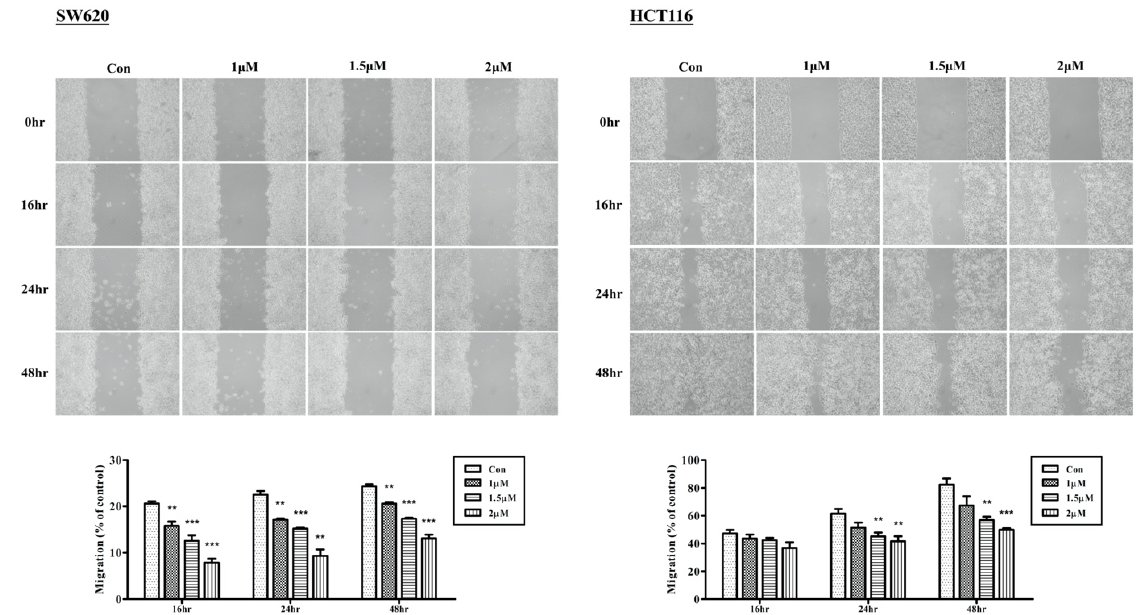
Figure 2. Wound-healing assay and percentage of cell migration in cultured SW620 and HCT116 cells 0, 16, 24, and 48 h after treatment with Arylquin 1; quantitative data are expressed as mean ± SEM. ** p < 0.01 and *** p < 0.001 compared to the control group. To evaluate cell invasion, we used a Matrigel invasion assay. In both SW620 and HCT116 cells, 1, 1.5, and 2 μ M Arylquin 1 significantly inhibited cell invasion 24 h after